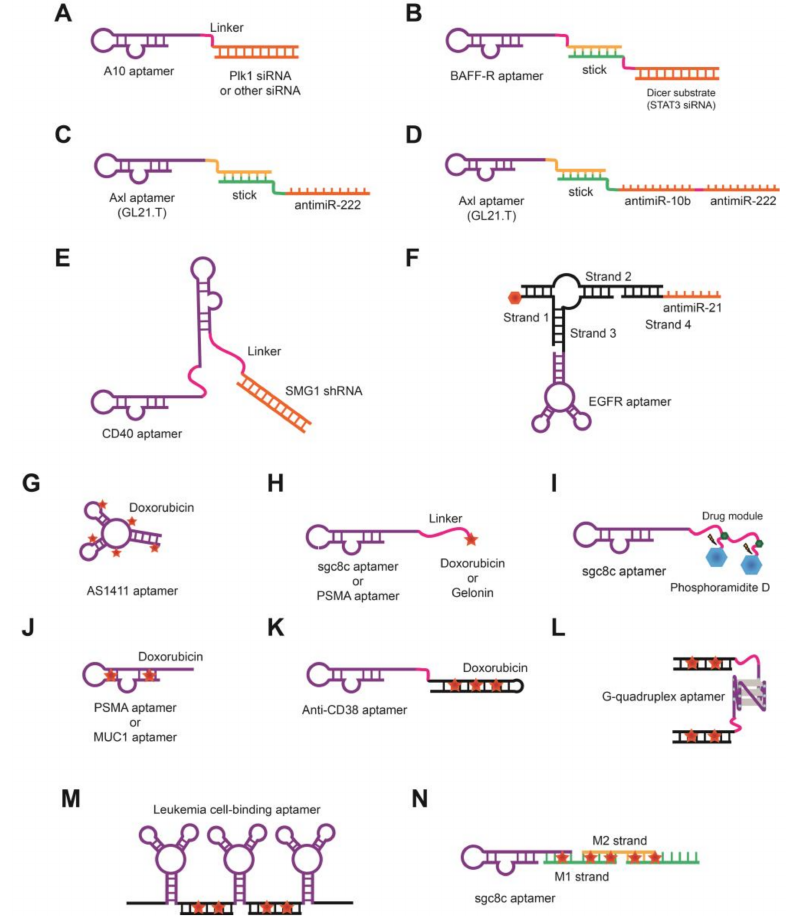
Figure 2. Schematics of aptamer-oligonucleotides and aptamer-drug conjugates. ( A ) Aptamer-siRNA conjugate. A PSMA aptamer is covalently conjugated with Plk1 siRNA via a linker; ( B ) Aptamer stick sequence-siRNA conjugate. A BAFF-R aptamer is complexed with STAT3 siRNA via a pair of complementary stick sequences; ( C ) Aptamer stick sequence-miRNA conjugate. The stick sequence (17-mer) of the GL21.T aptamer and extended stick sequence of anti-miRNA-222 at the 3 (cid:48) -end are fully annealed; ( D ) Aptamer stick sequence-dual anti-miRNA conjugate. Anti-miRNA-10b and anti-miRNA-222 are conjugated with the GL21.T aptamer; ( E ) Bivalent aptamer-shRNA conjugate. Two CD40 aptamers are conjugated with SMG1 shRNA; ( F ) Three-way junction-aptamer-anti-miRNA conjugate. The trifunctional aptamer consists of four DNA strands containing EGFR aptamer, anti-miRNA-21, and Alexa 647 dye; ( G ) Aptamer-drug conjugate. An AS1411 aptamer is directly conjugated with Dox by incubation with formaldehyde; ( H ) Aptamer-linker-drug conjugate. An Sgc8c aptamer and Dox or PSMA aptamer and gelonin are conjugated via a linker; ( I ) Aptamer-multiple drug conjugate. Sgc8 aptamer is conjugated with modified phosphoramidite containing a photocleavable linker and an anti-cancer drug; ( J ) Drug-intercalating aptamer. Dox is loaded into double-stranded regions of the PSMA aptamer or MUC1 aptamer; ( K ) Aptamer-cargo conjugate. A CD38 aptamer conjugated with the CG-rich sequence of “CG cargo” carries Dox; ( L ) Aptamer-dual cargo conjugate. A G-quadruplex DNA aptamer is conjugated with two double-stranded DNAs carrying Dox by a linker; ( M ) Polyvalent aptamer-drug conjugate. Multiple aptamers specific to leukemia cells are synthesized by rolling circle amplification and Dox is loaded between the aptamer units; ( N ) Aptamer-tethered DNA nanotrains. An Sgc8c aptamer and two short DNA strands were assembled to form